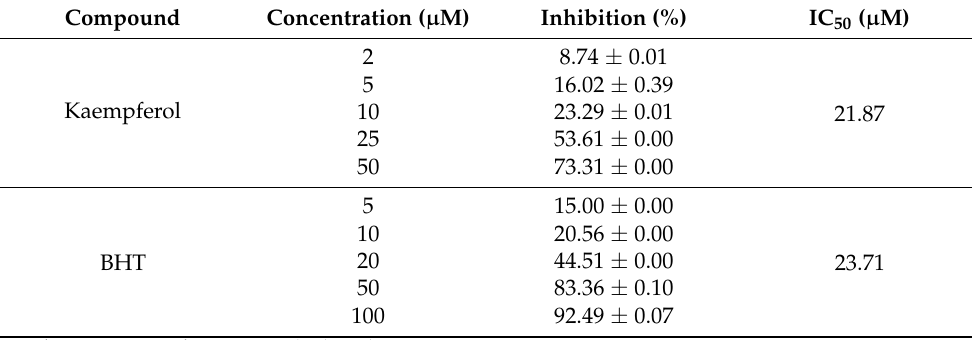
Table 2. Scavenging activities of kaempferol against the DPPH